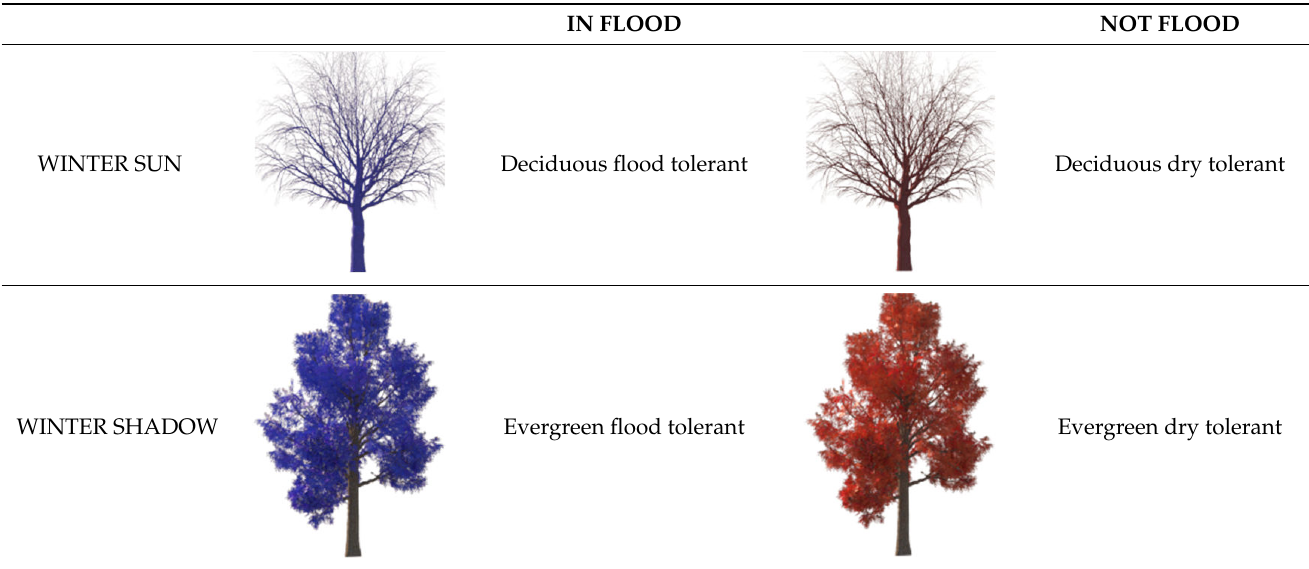
Table 2. Indicative tree types needed for each co-condition. Images by authors using Autodesk™ 3ds Max™ with Xfrog™ ExLevel GrowFX™